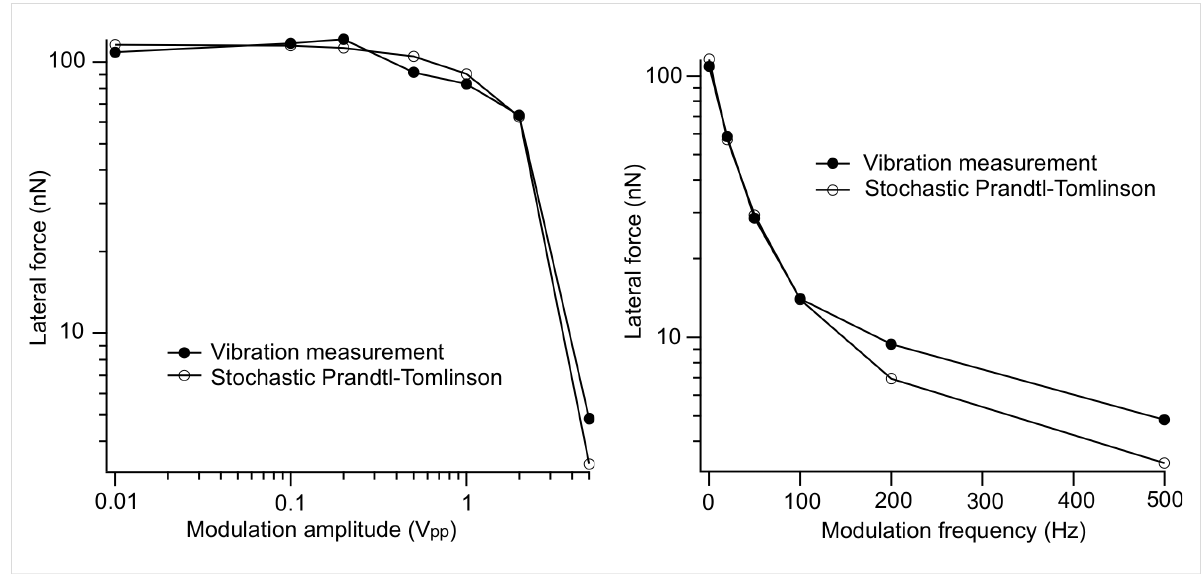
rise to the energy dissipation) it is able to predict the important features of the typical motion observed of a polycrystalline silicon MEMS slider as it slides against an on-chip counter- surface of same material. This proves that the overall sliding behaviour is governed by the mechanical locking statistics due to the roughness of the surfaces. We have also shown that this new model can be easily extended with a term that describes the modulation of the normal force as present in vibration-induced friction reduction strategies. This extended model predicts the critical features of the vibration experiments very